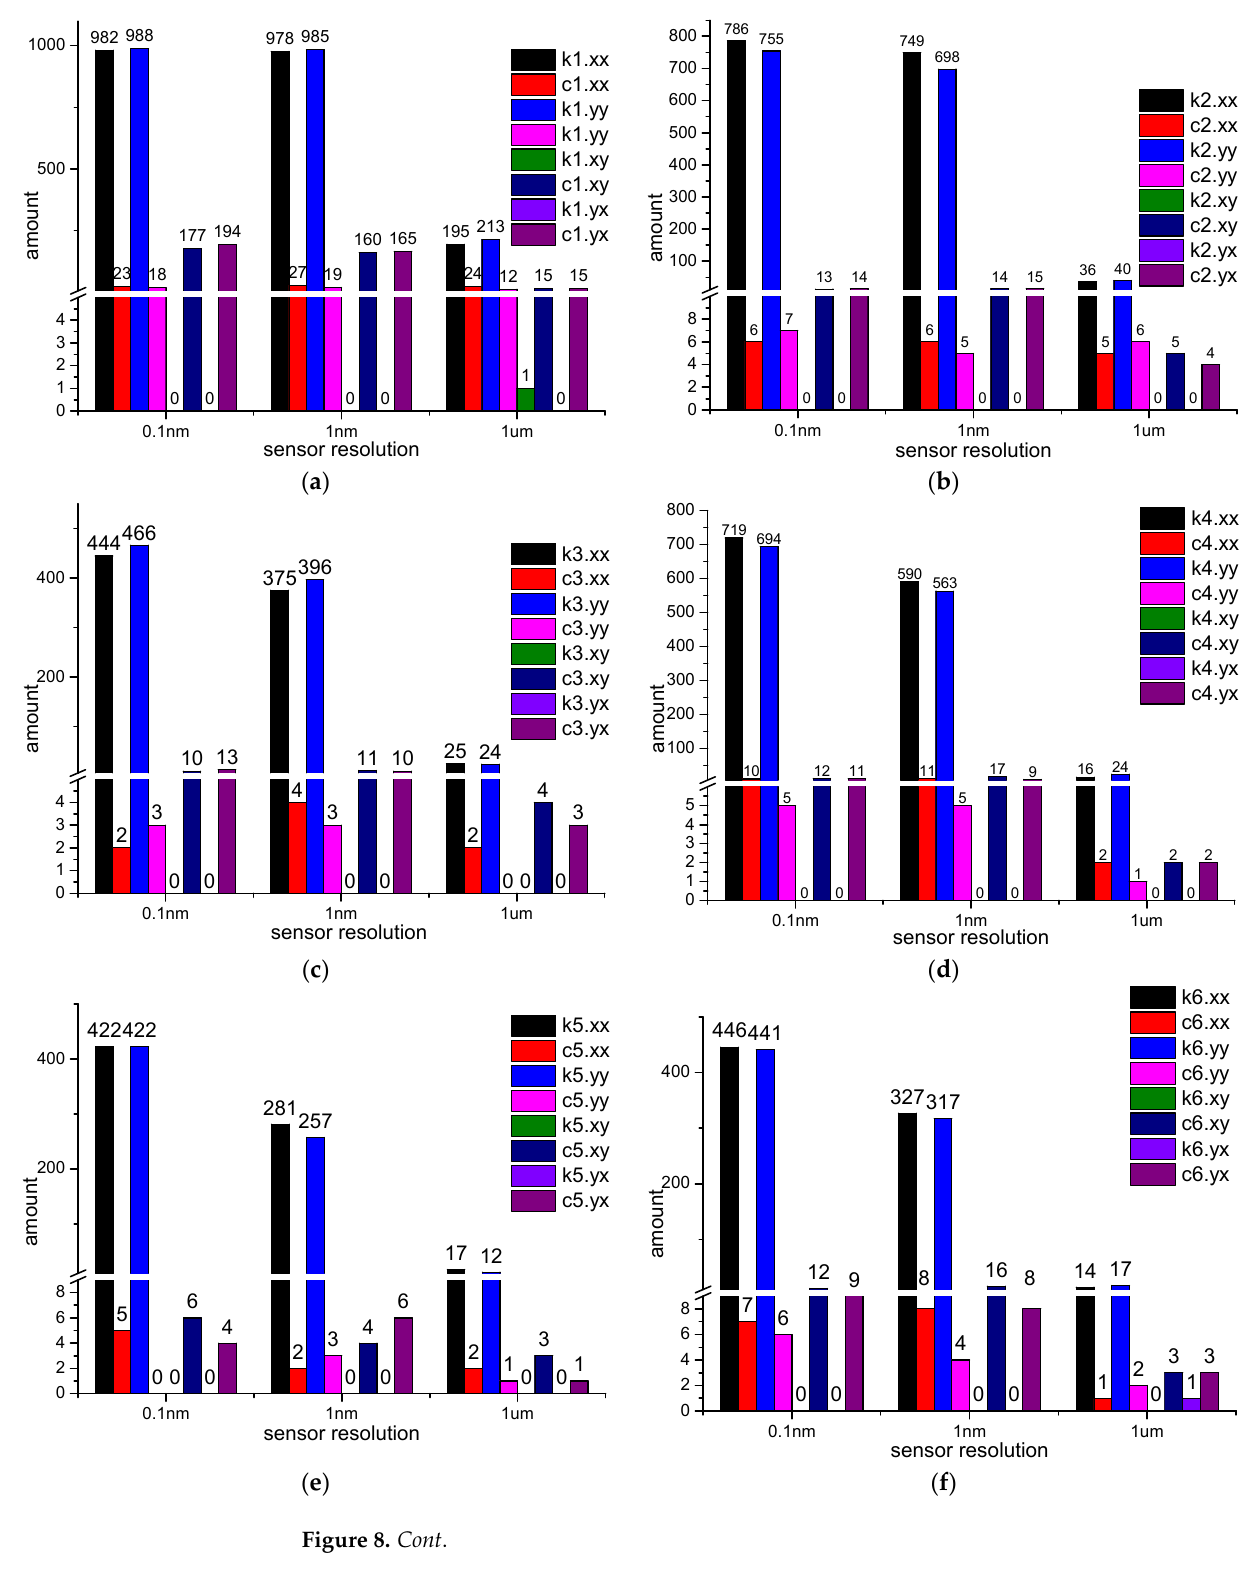
Figure 7. Statistical results of the amount of the frequencies, at which the related error is less than 10%: ( a ) #1 bearing; ( b ) #2 bearing; ( c ) #3 bearing; ( d ) #4 bearing; ( e ) #5 bearing; ( f ) #6 bearing; ( g ) #7 bearing; ( h ) #8 bearing.